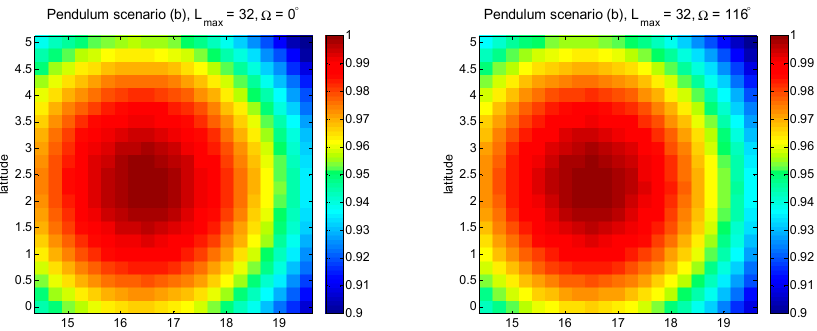
Figure 25. Spatial covariance of a selected point in West Africa (from Figures 19 and 20) for 6-day solution of the Pendulum formation up to L max = 32, for top: scenario (a), and bottom: scenario (b). Left is Ω = 0° and right is Ω = 116°.